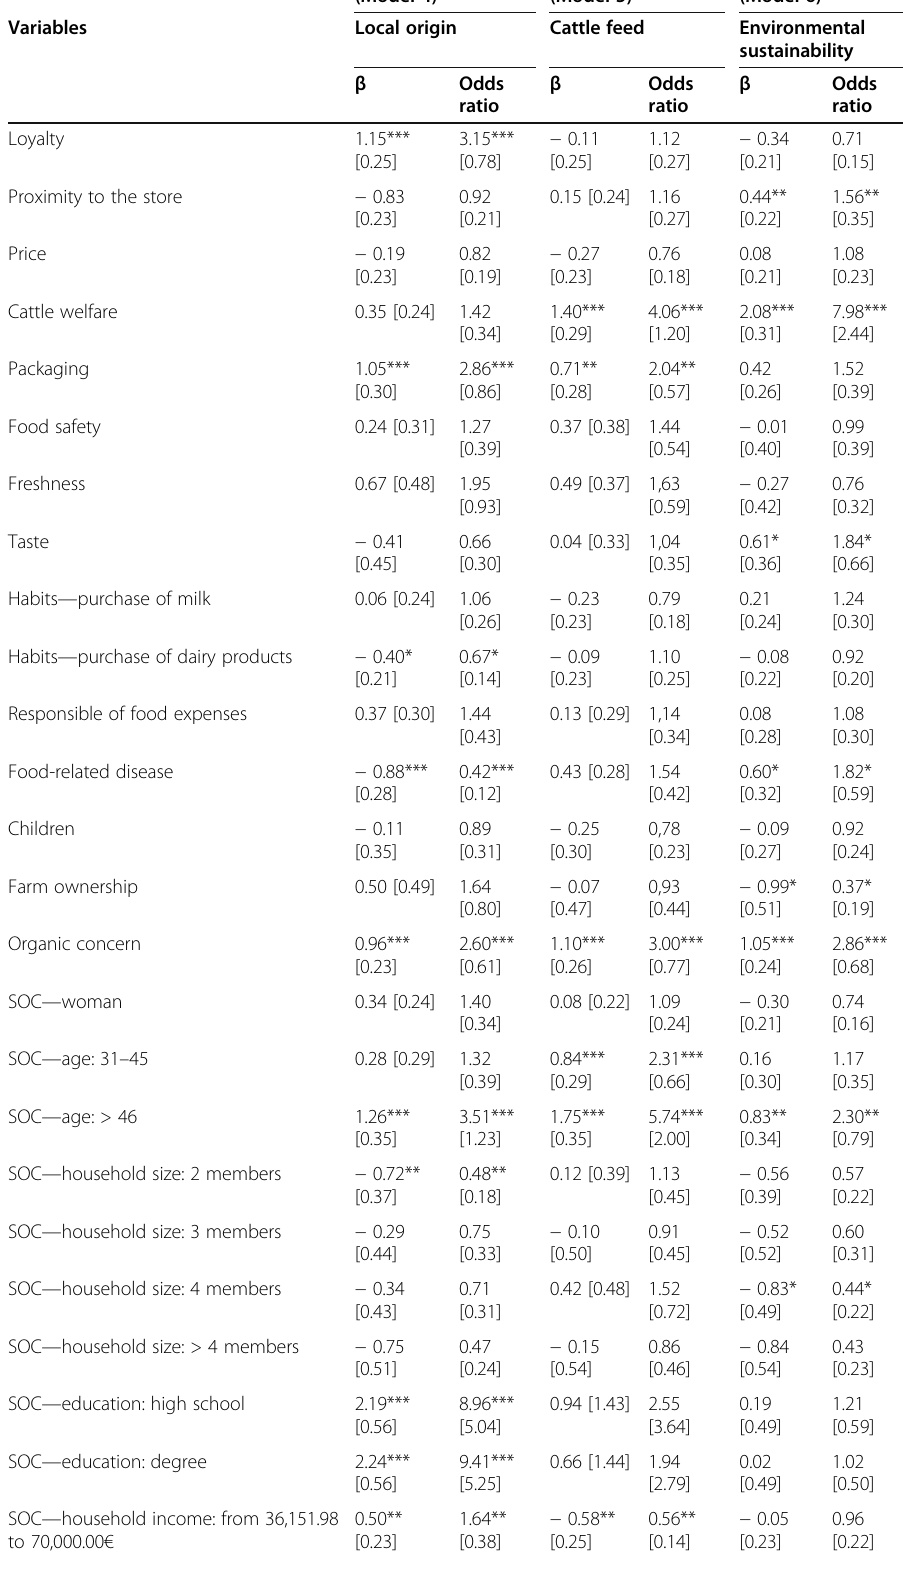
Table 4 Model estimation: beta coefficients and odds ratio for voluntary label